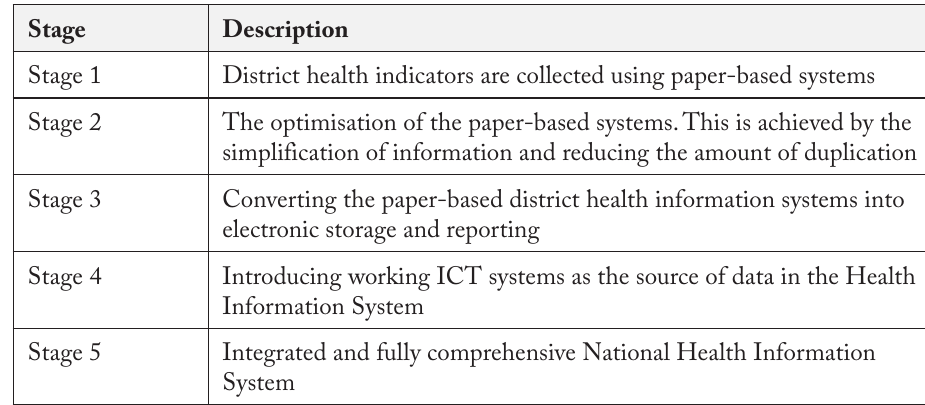
Table 3: Five stages of eHealth